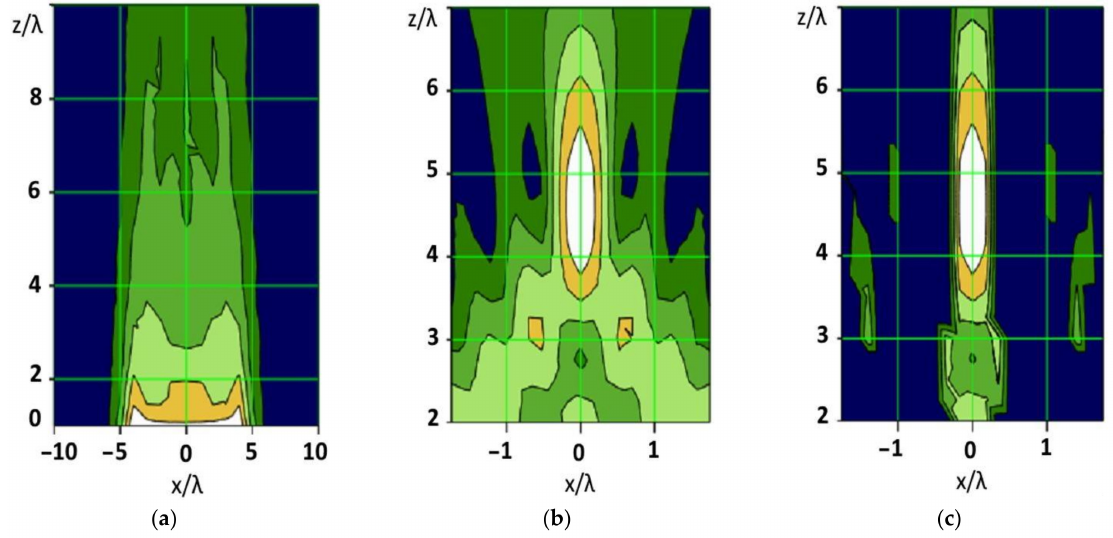
Figure 15. Spatial distributions in the near radiated field zone for antenna length 10 λ with a uniform phase distribution ( a ), focused to the point (0.5 λ ) ( b ), and focused to the point (0.5 λ ) with sum– difference processing ( c